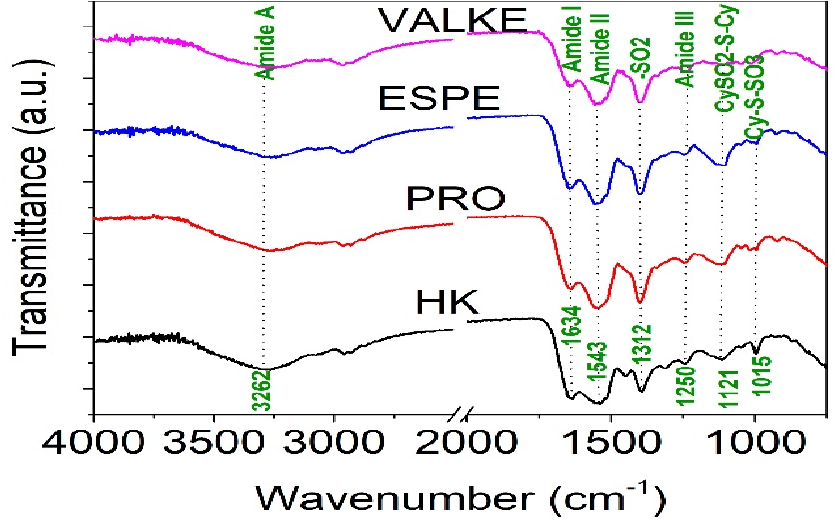
Figure 4. FTIR spectra for keratin hydrolysates: HK, PRO, ESPE, and VALKE.